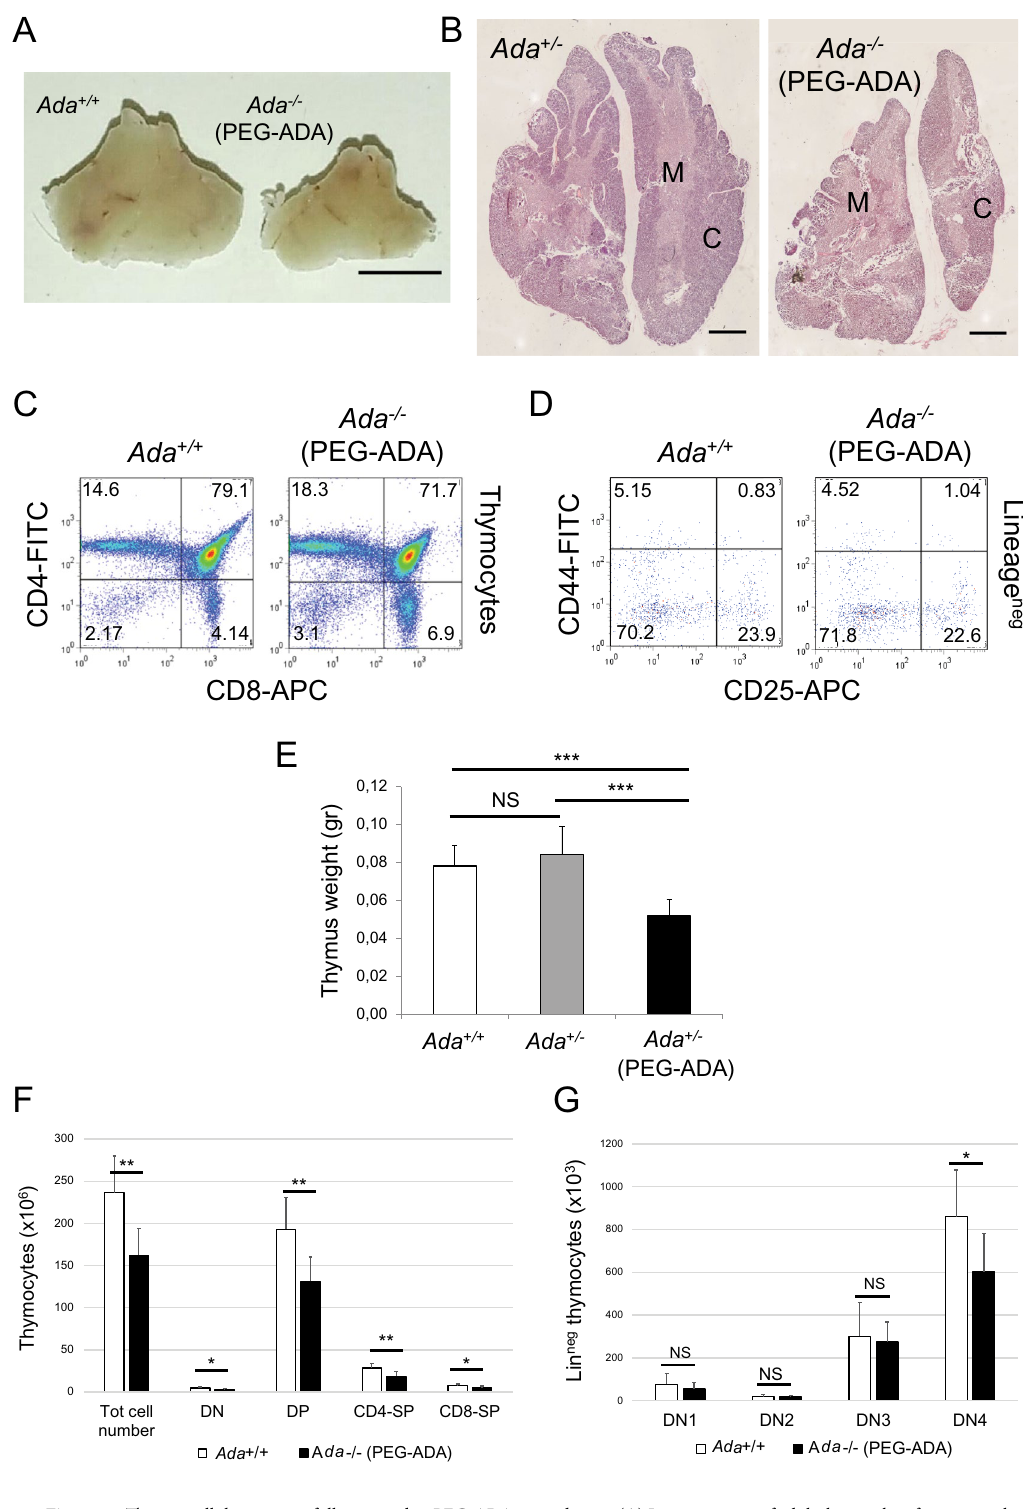
Figure 4. Thymus cellularity is not fully restored in PEG-ADA-treated mice. ( A ) In vivo images of adult thymi taken from control ( Ada + / + ) and 3-month-PEG-ADA-treated ( Ada −/− ) mice. ( B ) H&E staining of paraffin-embedded thymus sections from control ( Ada + / + ) and 3-month-PEG-ADA-treated ( Ada −/− ) mice. C = cortex, heavily filled with developing immature thymocytes; M = medulla, contains a mixture of helper (CD4 +) and cytotoxic (CD8 +) T cells. ( C and D ) FACS analysis of unfractionated thymocytes gated for: DN (CD4 − , CD8 − ), DP (CD4 + , CD8 + ), CD4-SP (CD4 + , CD8 − ) and CD8-SP (CD4 − , CD8 + ) populations ( C ), and Lin neg thymocytes gated for: DN1 (CD44 + , CD25 − ) DN2 (CD44 + , CD25 + ) DN3 (CD44 − , CD25 + ) DN4 (CD44 − , CD25 − ) populations ( D ). All thymocytes were from control ( Ada + / + ) and 3-month-PEG-ADA-treated ( Ada −/− ) mice. ( E ) Bar graph representing weight of thymi from control ( Ada + / + and Ada +/− ) and 3-month-PEG-ADA-treated ( Ada −/− ) mice (n = 5, 7, 11). ( F and G ) Bar graphs representing absolute cell numbers of populations shown in (C) and (D) (n = 6, 7). * P < 0.05, ** P < 0.01 and *** P < 0.001. NS = statistically not